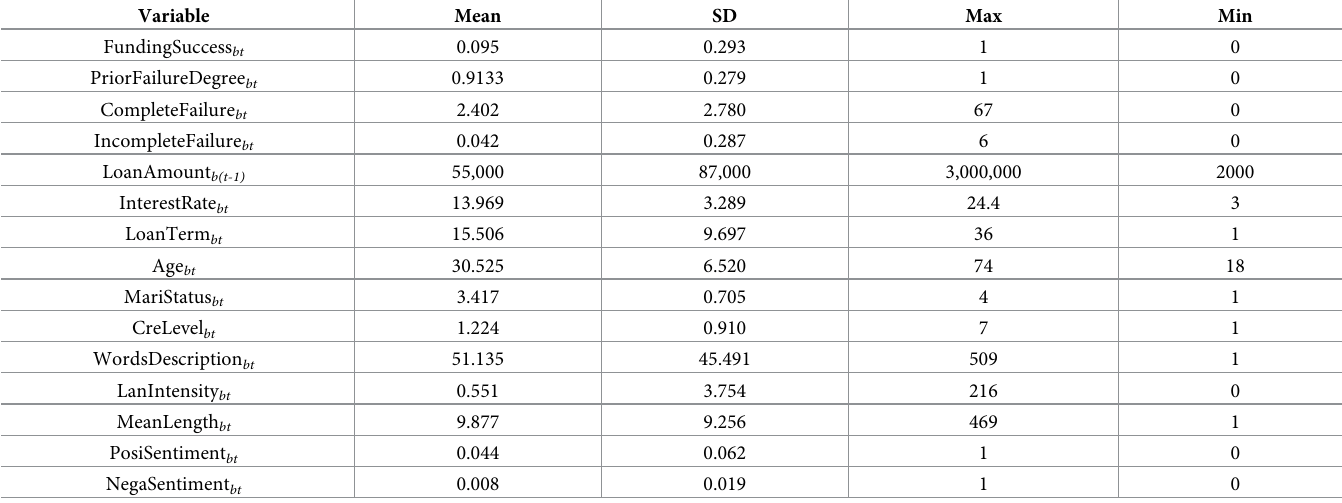
Table 3. Descriptive statistics for the data sample from